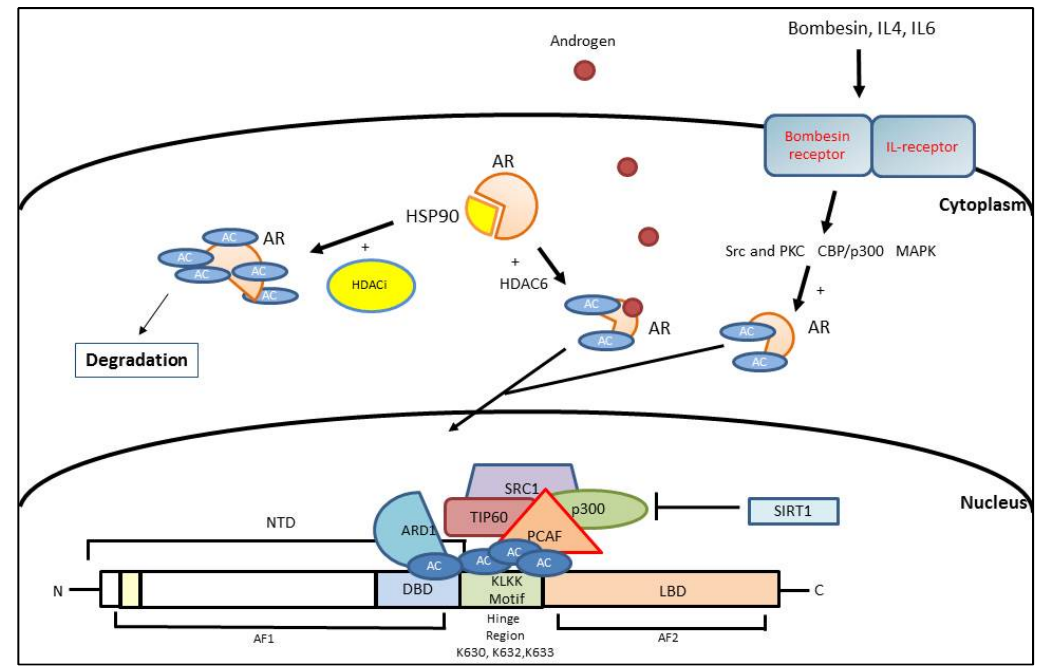
Figure 2. Graphic representation of the balance between acetylation and deacetylation in the regulation of androgen receptor (AR) gene expression. The mechanism of action of histone deacetylase inhibitors (HDACi) such as romidepsin and panobinostat is related to the heat shock protein-90 (HSP90). NTD: N-terminal domain; DBD: DNA binding domain; LBD: ligand binding domain; AF1 and AF2: activation function 1 and 2; PKC: protein kinase C; SRC1: steroid receptor coactivator-1; TIP60: Tat-interactive protein, 60 kDa; ARD1: N -acetyltransferase arrest-defect 1; SIRT1: Sirtuin 1; PCAF: p300/cAMP-response element-binding protein associated factor.